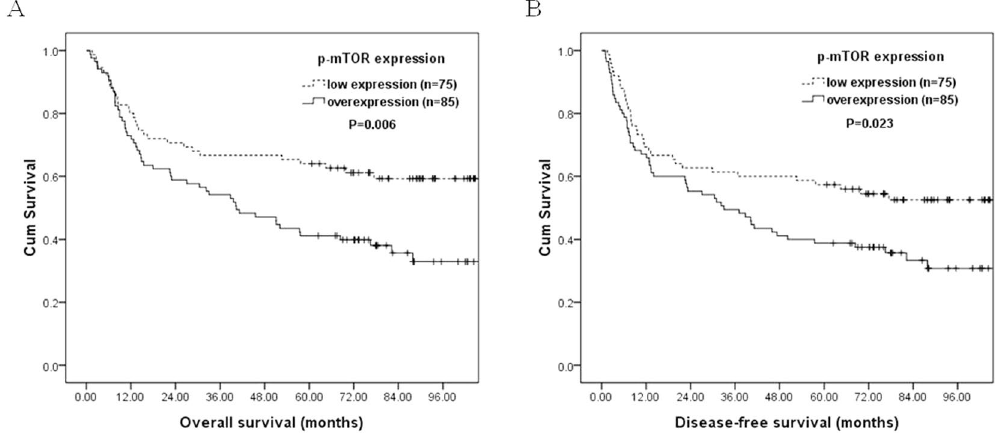
Figure 2. Kaplan–Meier plots to predict overall survival and disease-free survival according to p-mTOR protein immunoexpression. Tongue squamous cell carcinoma patients with p-mTOR overexpression have significantly shorter overall survival ( A ) and disease-free survival ( B ) than those with low p-mTOR